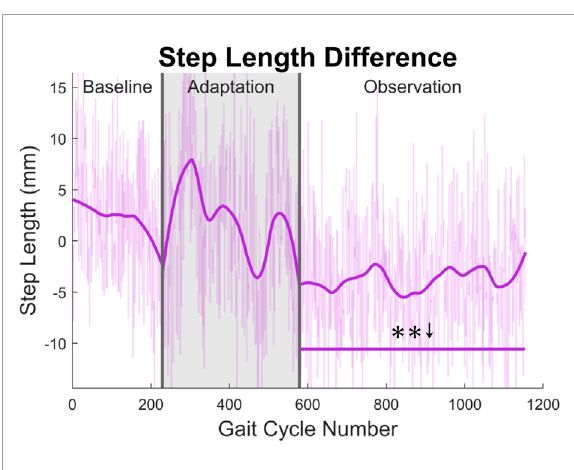
FIGURE 5 Step length asymmetry averaged for all 12 subjects. Step length was calculated as the projected distance between ankles in the floor plane at the time of heel strike. For this figure, step length asymmetry was found by subtracting right step length from left step length. The right step length is significantly greater for the entire observation phase, as indicated by the significance line. All significance testing was performed on “unsmoothed” data (seen in the lighter line). The darker line is the data smoothed by 2nd-degree polynomial local regression and was added only to allow the reader to more clearly see trends in the